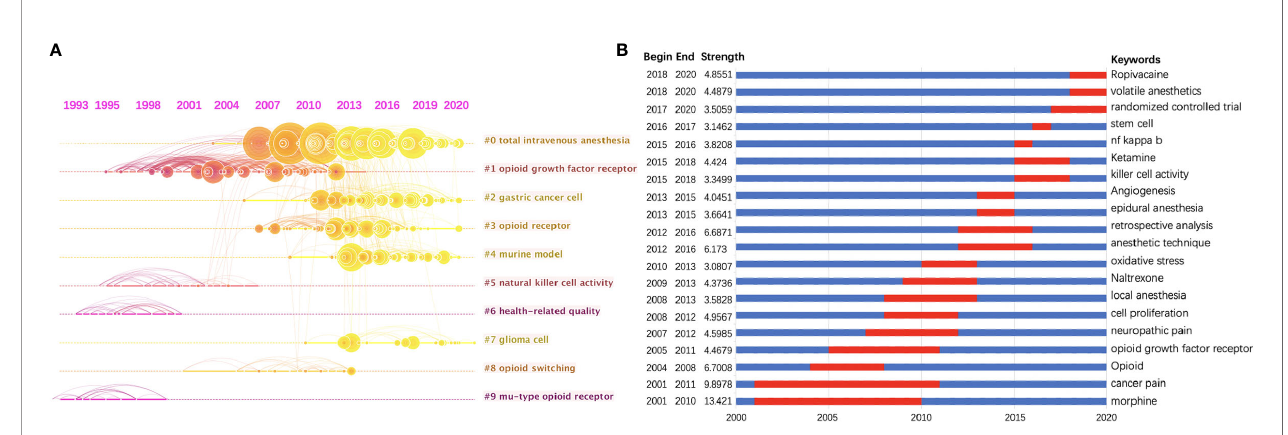
FIGURE 5 | (A) Timeline view of the top 10 largest clusters of citing articles in the fi eld of anesthesia and cancer research. Right side = cluster labels. (B) Keywords with the strongest burst strength of the 1494 citing articles on anesthesia and cancer research between 2001 and 2020. Keywords marked in red indicates a sudden increase in usage frequency of this keyword during that period. Blue represents a relatively unpopular time